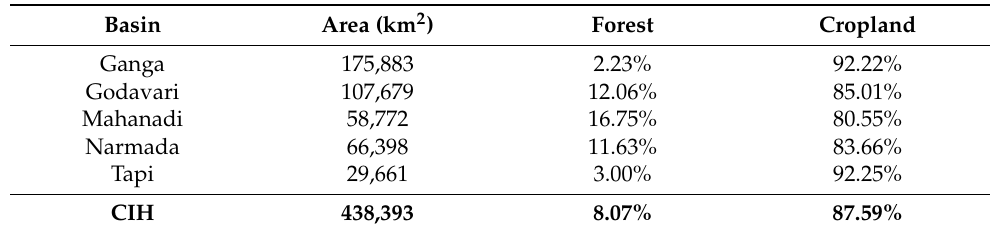
Figure 1. Central Indian highlands with the five major basins delineated. Forest cover is shown in green while agriculture is in yellow derived from the European Space Agency (ESA) Land Cover 2010 data reclassified. The inset map shows the sampling area for infiltration tests and the final sampled locations. The color of the sample locations represents the land cover. Table 1. Basin area and forest cover from ESA Climate Change Initiative 300 m Land Cover Data (CCI) land cover